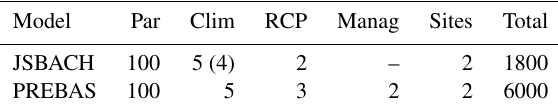
Table 1. Composition of JSBACH and PREBAS model simulations: number of parameter combinations (Par), climate models (Clim), RCP scenarios (RCP), management actions (Manag) and sites as well as the total number of 120-year-long